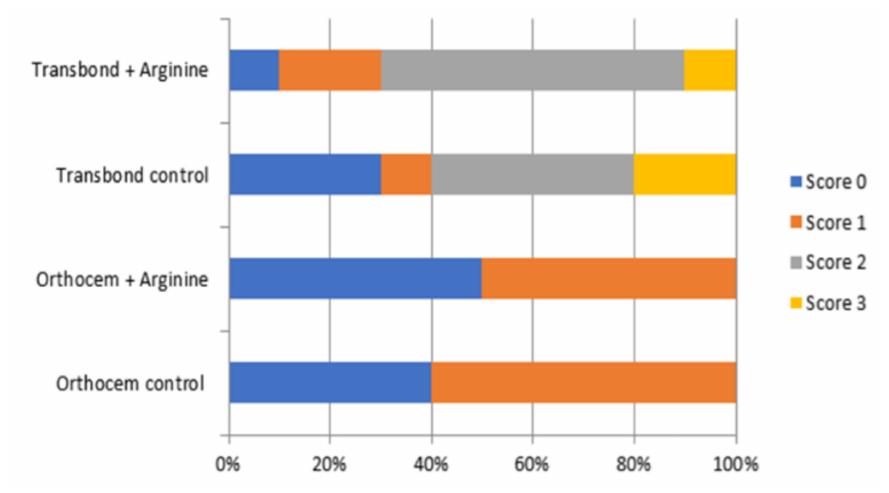
Figure 1. Image for the adhesive remnant index (ARI) for the material